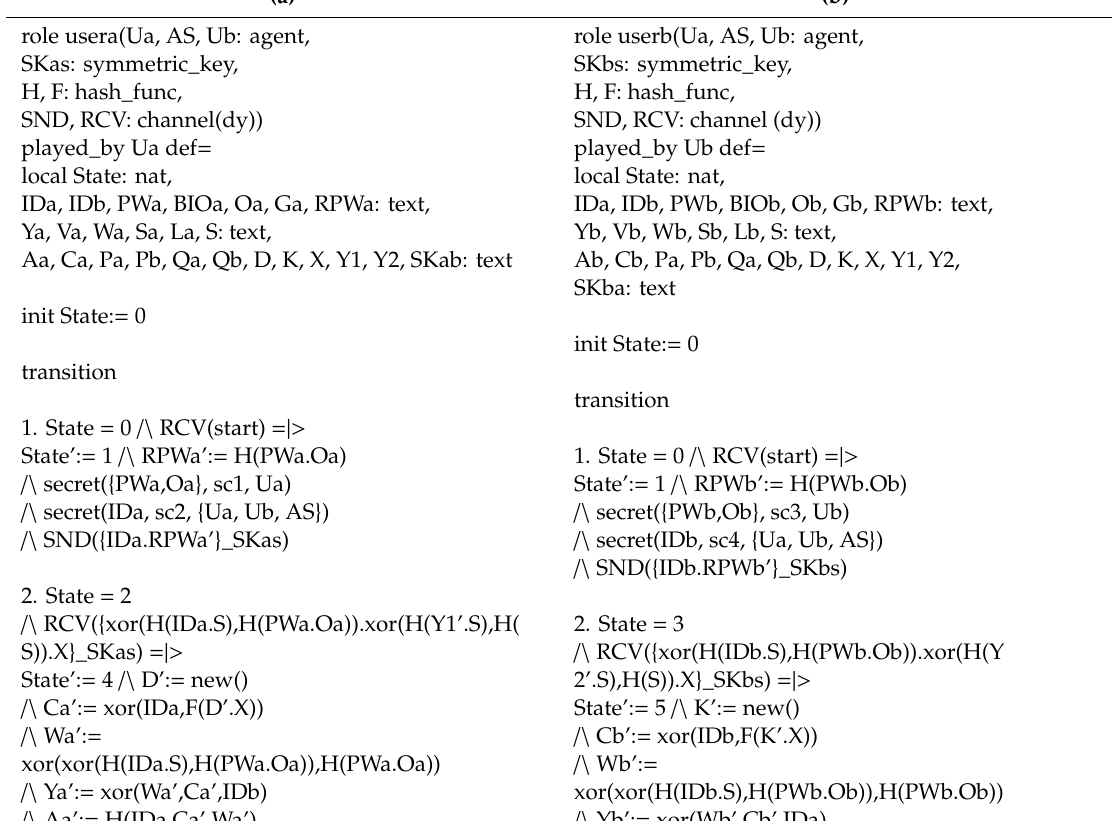
Table 2. Role specification for ( a ) user U A , ( b ) user U B , ( c ) user S , ( d ) session, goal, and environment. (a)